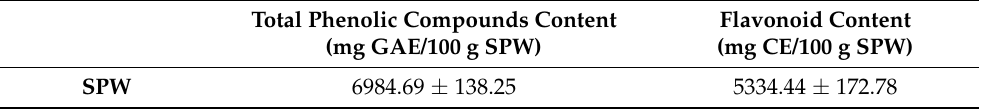
Table 2. Total phenolic compounds and flavonoid content of Salvia plebeia R. Br. water extract